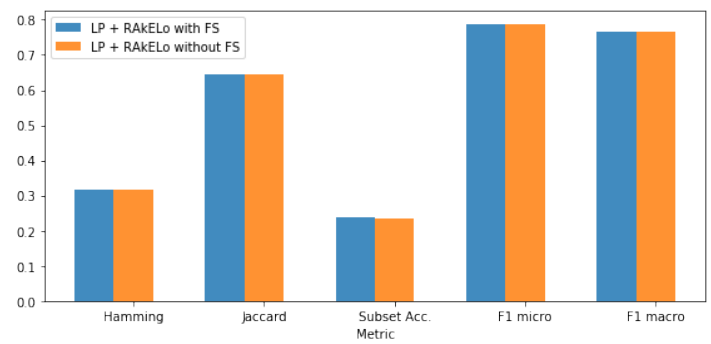
Figure 3: Comparison of the impact of feature selection (FS) on